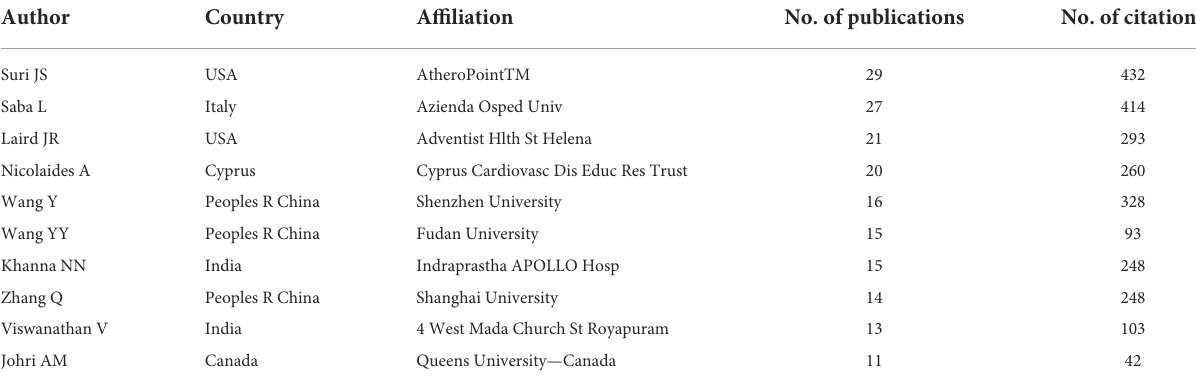
TABLE 4 Top 10 authors with most numbers of publications related to the use of AI in ultrasound.